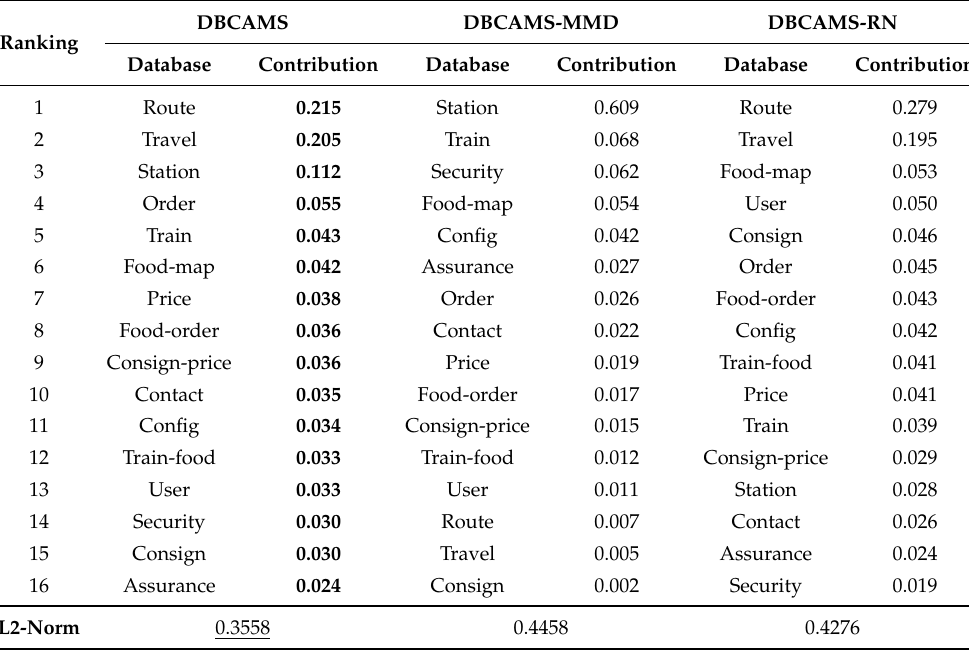
Table 13. The main results of TrainTicket. The best result of L2-Norm is underlined, and the databases’ contributions of the corresponding method are in bold ( ( α , β , γ , δ ) = ( 2,4,3,1 )